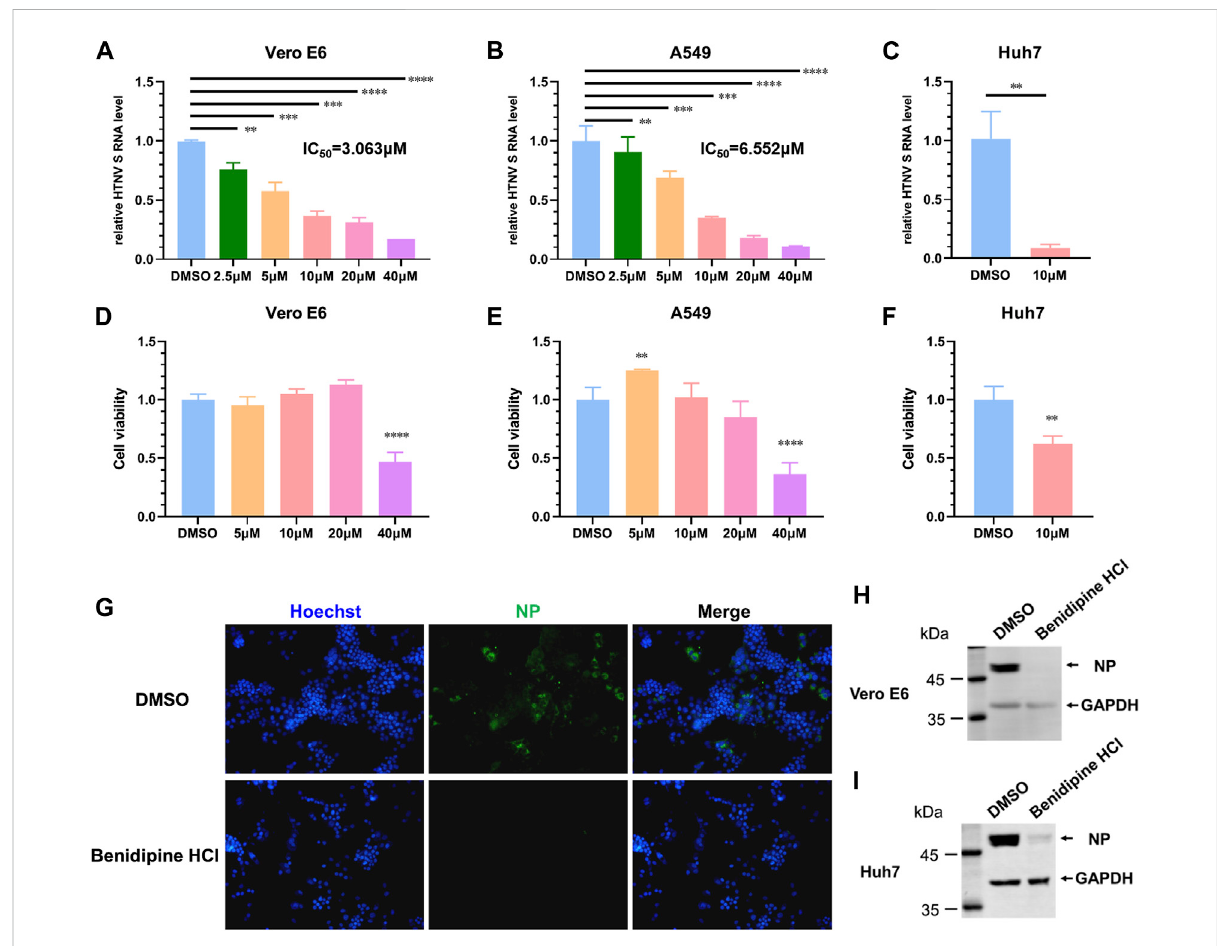
FIGURE 1 Benidipine hydrochloride inhibits HTNV infection. (A – C) Benidipine hydrochloride inhibited HTNV in Vero, A549, and Huh7 cells with dose- dependent effects. Benidipine hydrochloride was applied to cell monolayers at the indicated concentrations for 1 hour, and then, HTNV was inoculated at MOI 1 with the same concentrations of benidipine hydrochloride. After adsorption, the inoculum was discarded, and benidipine hydrochloridewasaddedto thefresh medium.Total RNAwasextracted 24hpi, andtheHTNVSsegmentRNAlevel was measuredbyqRT-PCR and normalized to GAPDH. IC 50 was indicated in the panel (IC 50 refers to 50% inhibitory concentration). Vero cells (D) , A549 cells (E) , and Huh7 cells (F) were analyzed for viability using the CCK8 assay after 24 h of benidipine hydrochloride treatment. The inhibition of the expression of HTNV structural proteins by benidipine hydrochloride. (G – I) Vero cells were treated with 10 μ M benidipine hydrochloride and infected with HTNV; after 24 h of infection, coverslips were stained with the NP-speci fi c antibody 1A8 (G) . After being exposed to 10 μ M benidipine hydrochloride, Vero cells (H) orHuh7cells (I) wereinfectedwithHTNV.After24 hofinfection,cellswerelysedandimmunoblottedwiththeantibody1A8.Student ’ st-testwas used to compare mean values between the benidipine hydrochloride-treated group and the vehicle control group (DMSO). * p < 0.05; ** p < 0.01; *** p < 0.001; **** p <